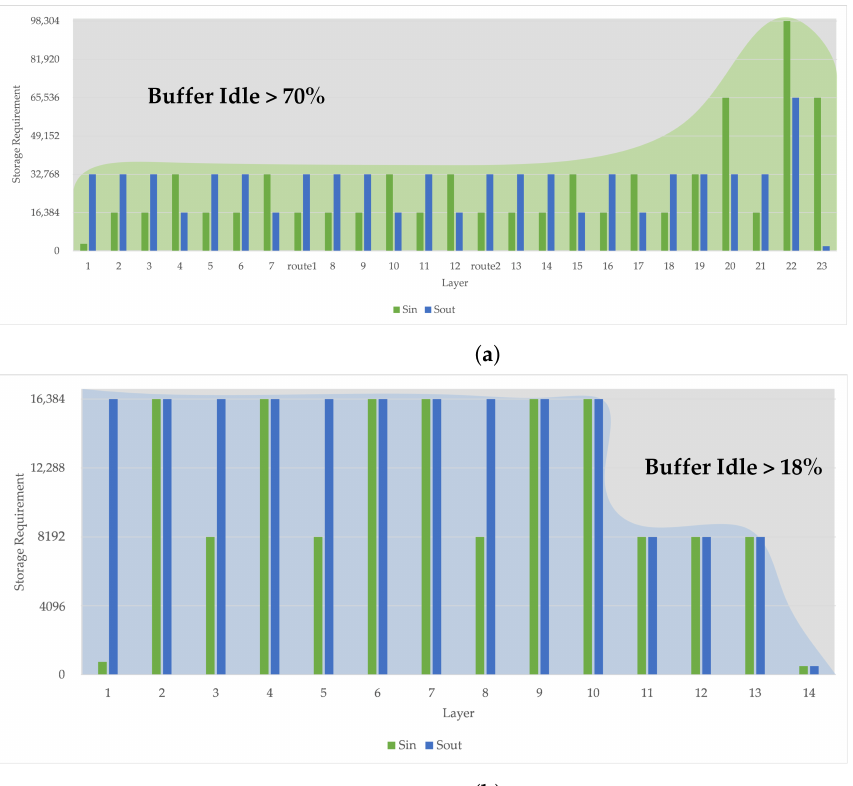
Figure 7. The statistical chart of storage requirements for each layer: ( a ) improved YOLOv2 network; ( b ) improved VGG16